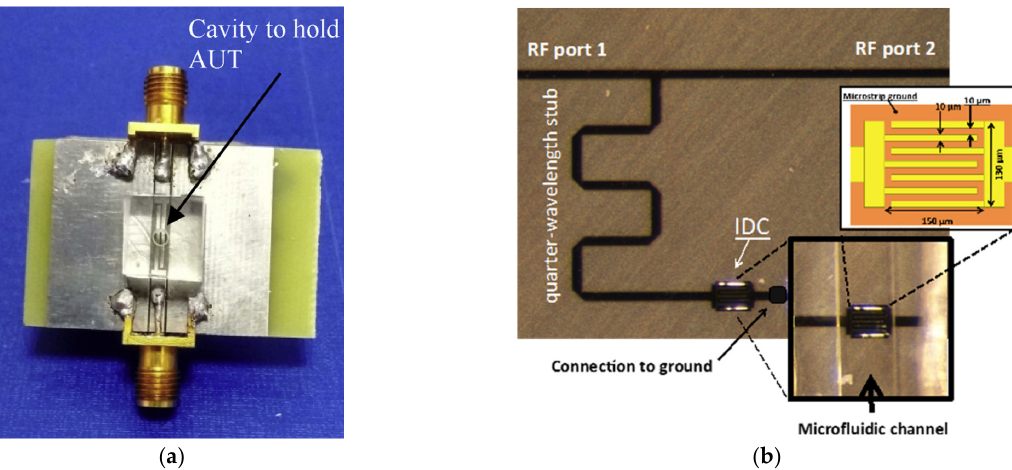
Figure 4. Examples of insertion/return loss-based sensors: ( a ) Coplanar interdigital capacitor sensor, reprinted from [129] with permission from Elsevier; ( b ) Quarter-wavelength stub connected to an interdigital capacitor structure for microfluidic measurements, reprinted from [141].